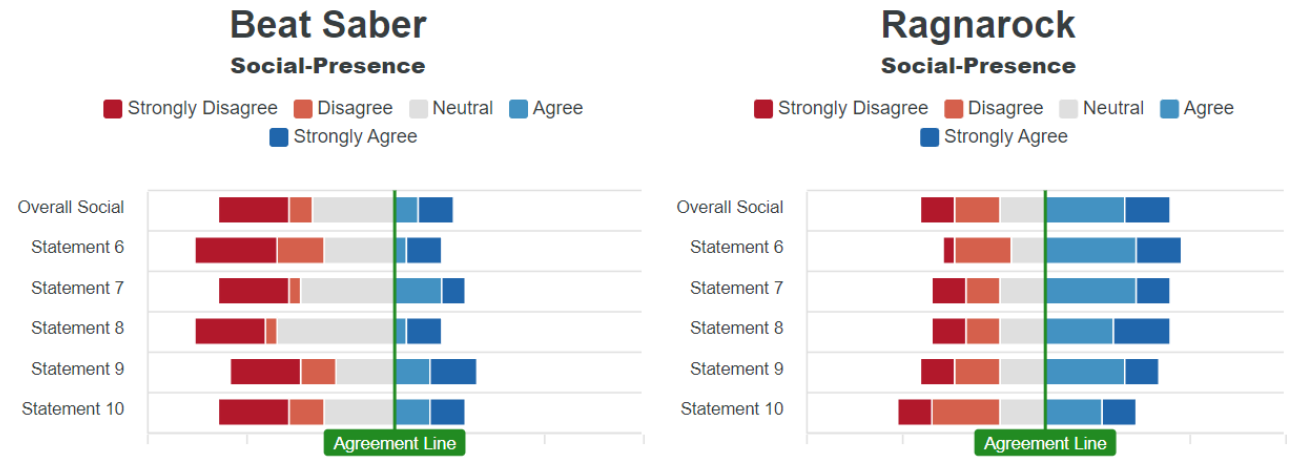
Figure 3. Comparison between social presence ratings for Beat Saber and Ragnarock. This shows low scores for social presence in Beat Saber (as expected) and average scores for Ragnarock. Additionally, Ragnarock scored significantly higher in statement 6 (“I felt like I was in the presence of another person in the virtual environment.”).